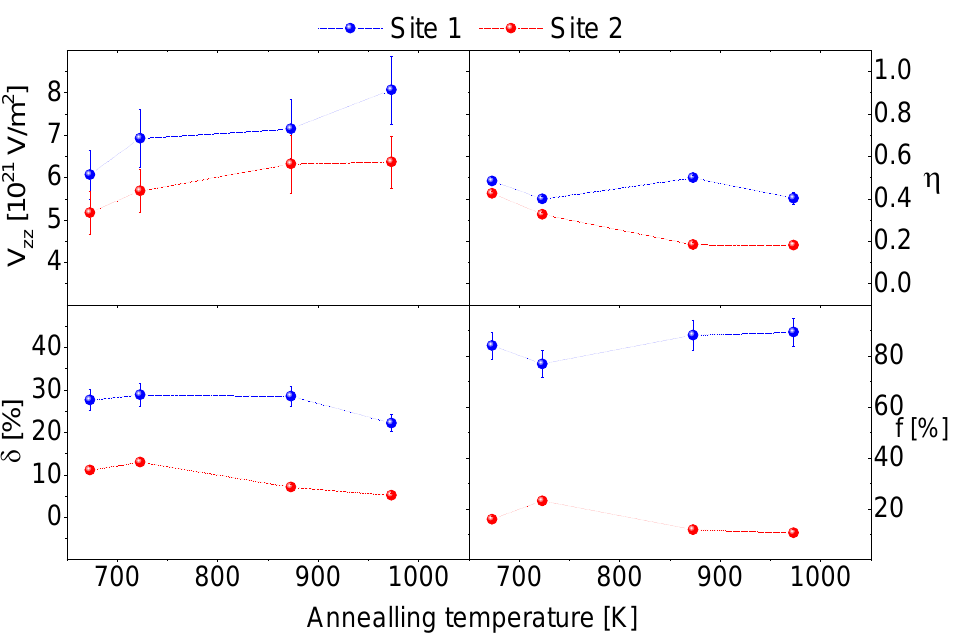
Figure 2. A graphic representation of the corresponding temperature dependence of the hyperfine parameters: the major component of the electric field gradient (EFG) (V zz ), the asymmetry parameter ( η ), the frequency distribution ( δ ), and the population of probe nuclei site fraction (f). Dotted lines are a guide for the eyes.